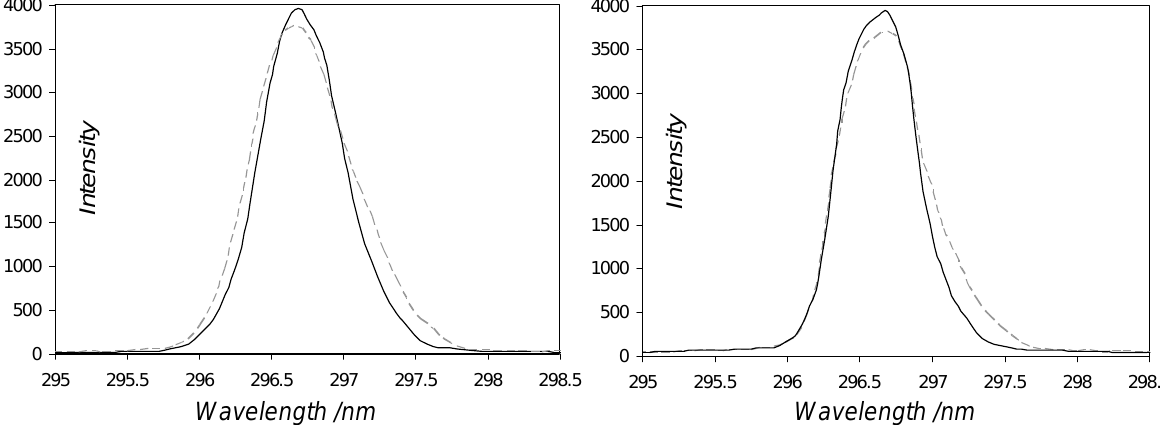
Figure 4. Thermal variation in the profile of the 296.7 nm line in the Hg lamp experiments. Traces at 12  C are dashed, and solid for 32  C, showing heating induced line narrowing from  0.8 nm to 0.65 nm for USB2G1110 (left) and from  0.7 nm to 0.6 nm for USB2G2385